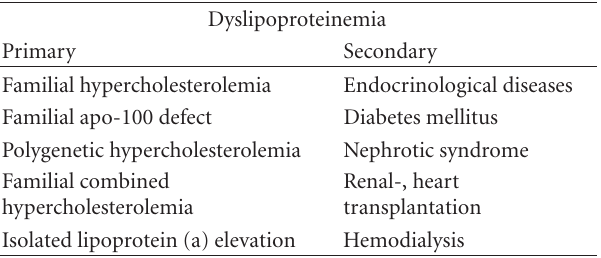
Table 2: Possible indications for extracorporeal elimination of Cholesterols